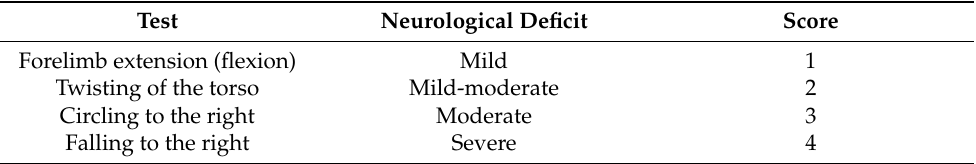
Table 1. Interpretation of the neurological impairment test. Points were given if the animal failed to extend both forelimbs and/or showed flexion of the contralateral forelimb when held above a flat surface (1 point); animal held by its tail showed twisting of the torso to the ipsilateral side (+1 point); animal showed a tendency to circle to the contralateral side when allowed to freely move (+1 point); and was falling to the contralateral side when allowed to freely move (+1